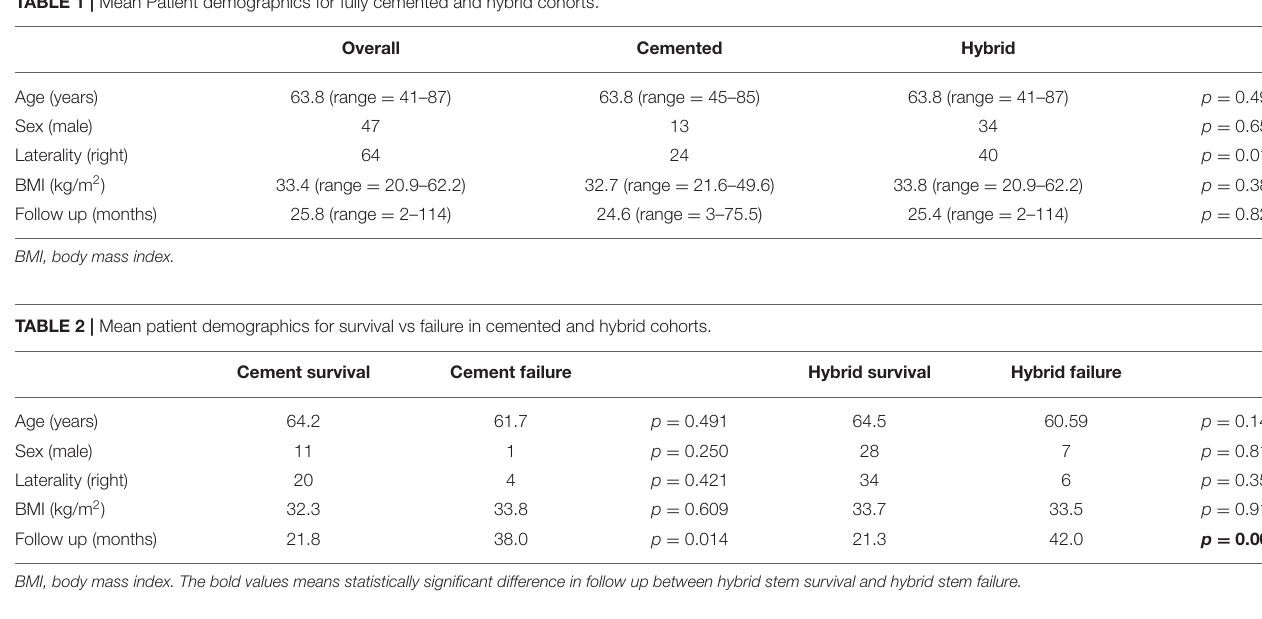
TABLE 1 | Mean Patient demographics for fully cemented and hybrid cohorts.